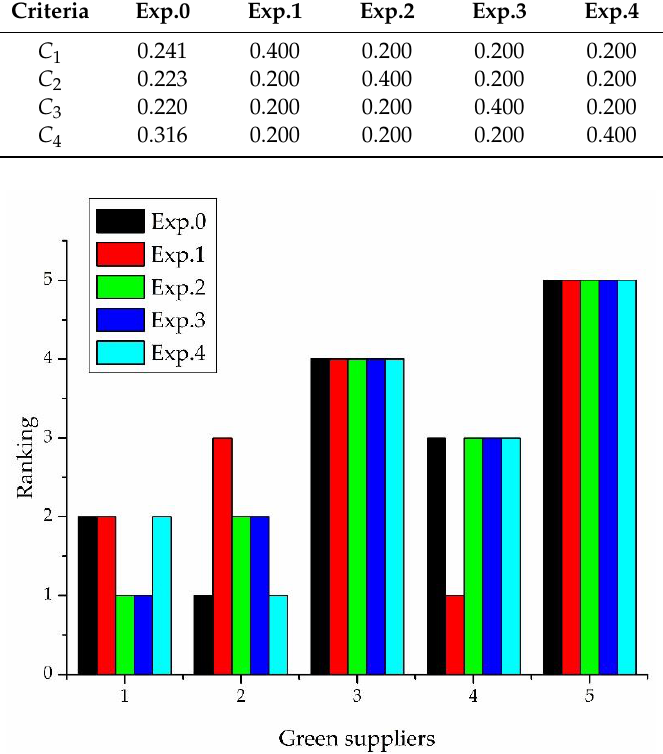
Figure 4. Rankings of sensitivity analysis. Figure 4 indicates that the ranking order of green supplier